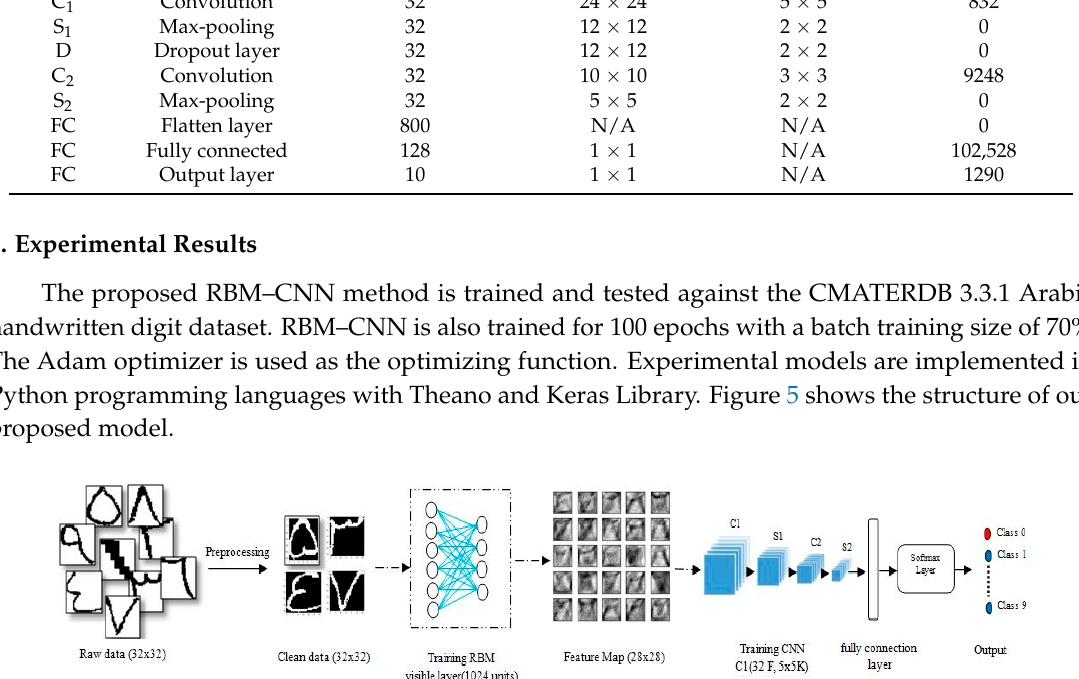
Table 2. Dataset description.